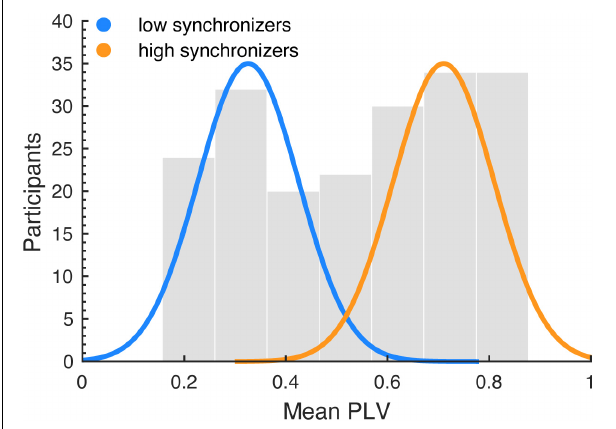
FIGURE 1 | Auditory-motor coupling strength was estimated using the spontaneous speech-motor synchronization test (Assaneo et al., 2019a). The histogram shows the distribution of the mean PLVs (averaged across runs) computed between the speech production and perceived audio signals, for the whole sample (including the samples of both studies). A k-means algorithm was employed to segregate the population into two clusters: low (LOWs) and high (HIGHs) synchronizers. The blue and orange lines indicate normal distributions fitted to each